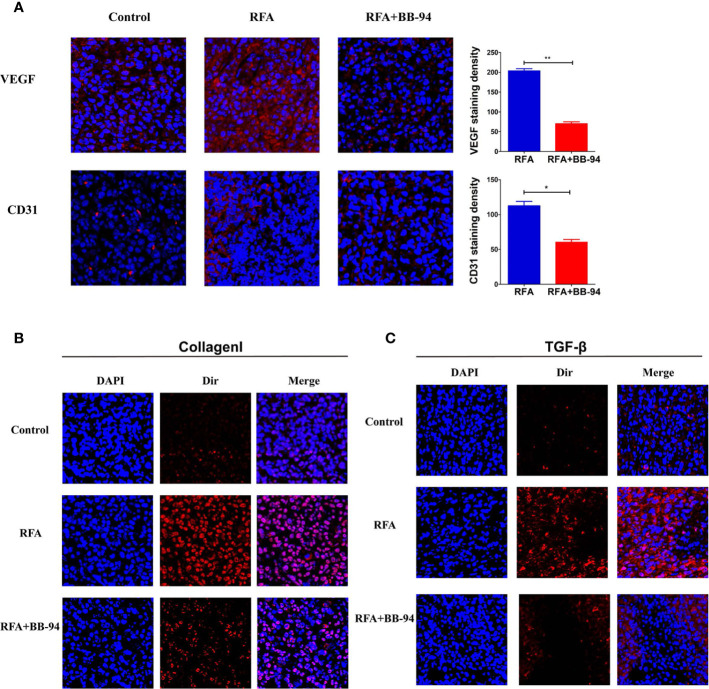
Assessment of pathologic findings was performed 48 h after the last injection of BB-94. (At the magnification of ×200) (A) The represented picture of VEGF and CD31 staining after different treatment and the semiqualitative analysis of VEGF and CD31 staining in the RFA group and RFA+BB-94 group. (B) The represented picture of Collagen I staining after different treatment. (C) The represented picture of TGF-β staining after different treatment. *P < 0.05, **P < 0.01.